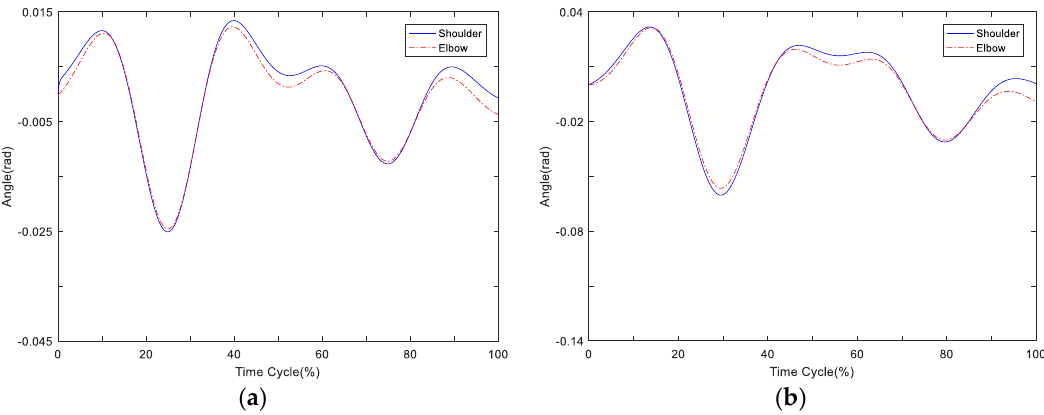
Figure 10. The tracking errors for upper limb joints: ( a ) adaptive neural network control with fuzzy compensation; ( b ) radial basis function neural network (RBFNN) control based on computational torque method.